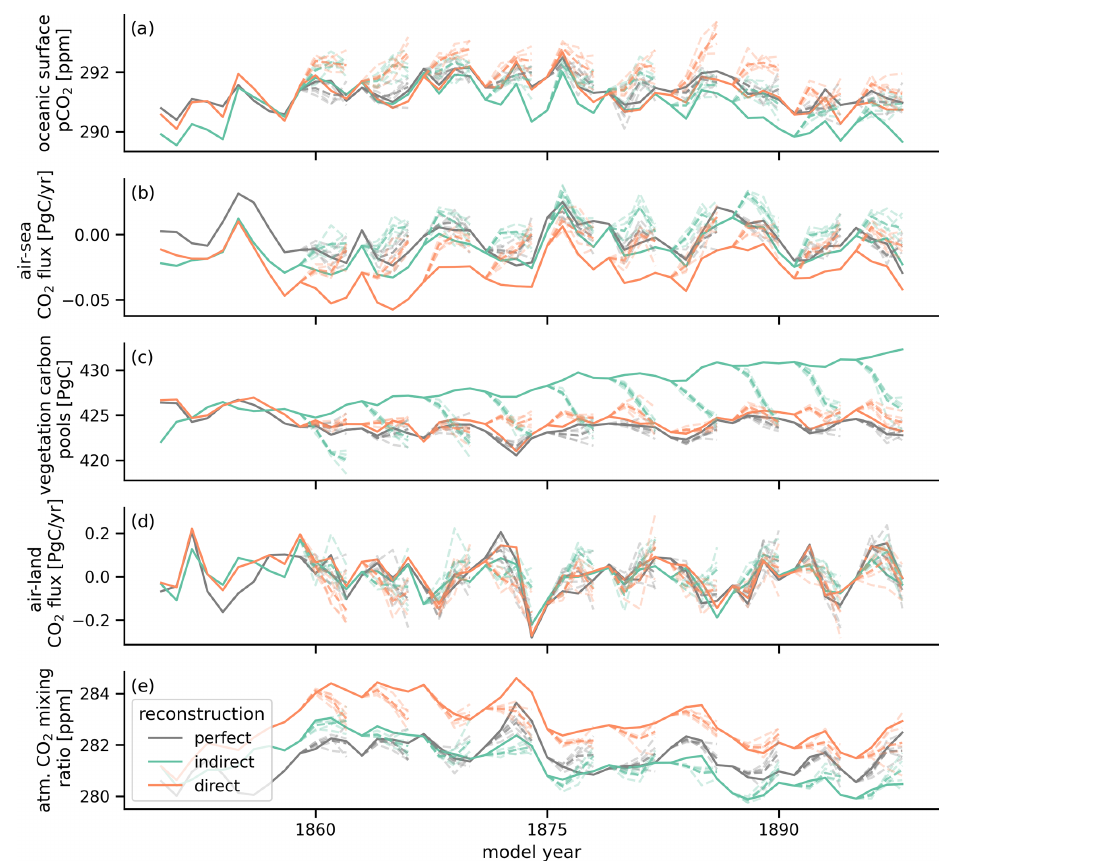
Figure 4. Evolution in global annual mean of (a) surface ocean p CO 2 (b) , air–sea surface CO 2 flux (negative values indicate carbon uptake by the ocean) (c) , vegetation carbon pools (g–i) , air–land surface CO 2 flux (negative values indicate carbon uptake by land) (d) and atmospheric CO 2 mixing ratio (e) . The target (gray) is quite well tracked by the indirect (green) and direct (orange) carbon cycle reconstruction. The solid line shows the different reconstruction simulations, the dashed lines show the initialized ensembles started from the different